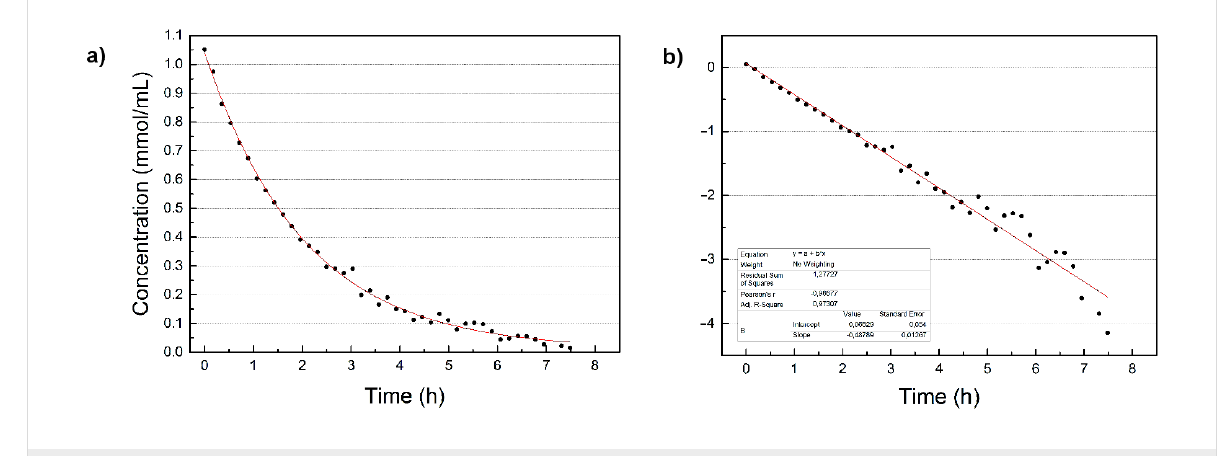
Figure 2: a) The decay of 2b in toluene- d 8 at 35 °C. b) The plot of log( Δ [ 2b ]) vs time.